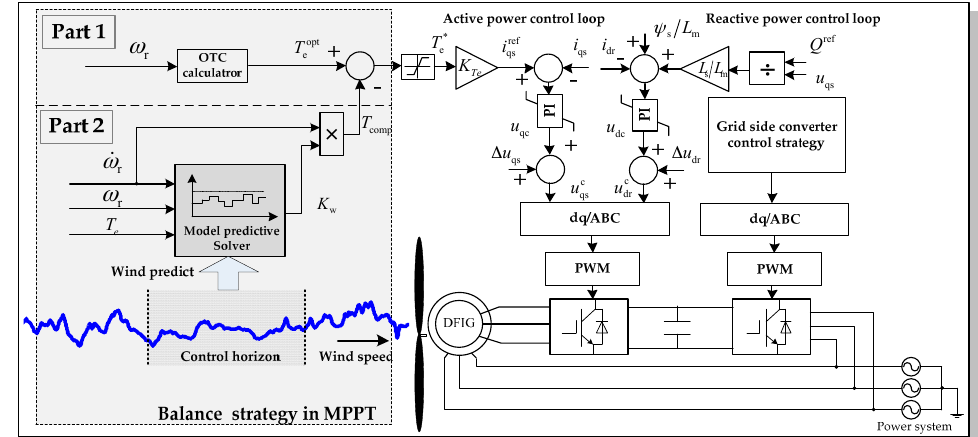
Figure 5. Proposed control framework with predictive method.